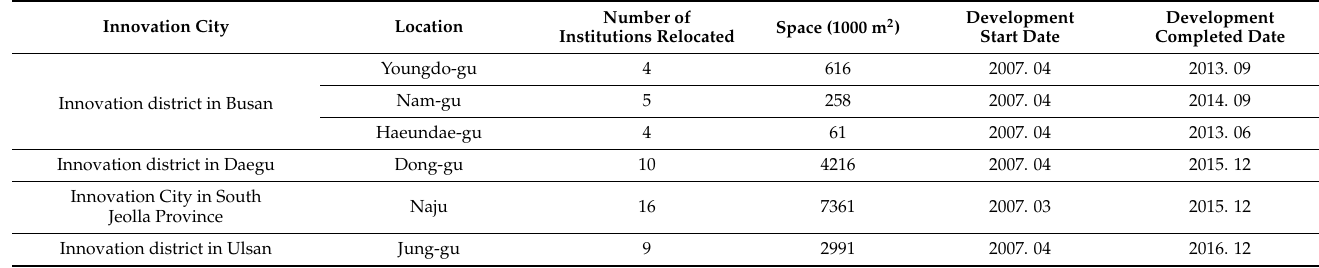
Figure 2. Innovation Cities Districts in South Korea. Table 1. Status of Innovation City